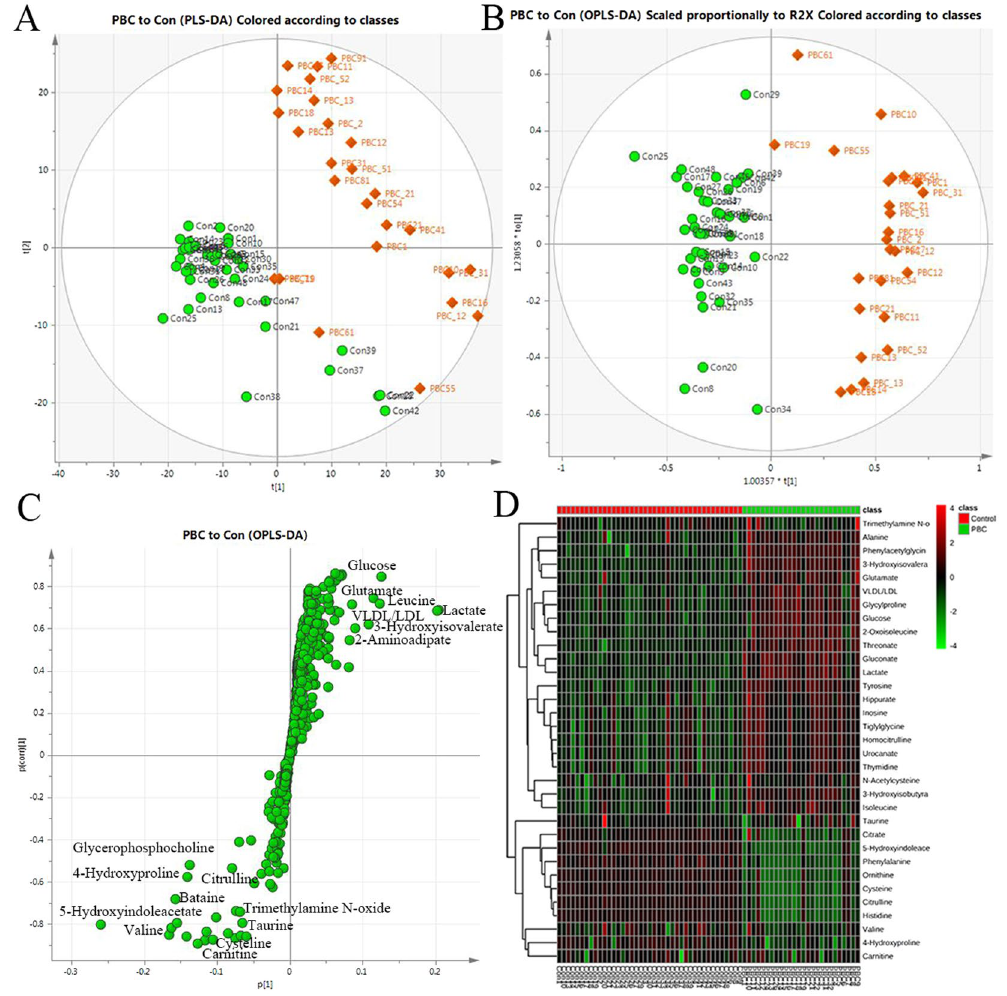
Figure 3. The serum PCA score plot ( A ), OPLS-DA ( B ), S-plot ( C ) and heat map ( D ) used to classify the PBC patients and healthy controls gained a clear separation and identified 33 metabolites. These metabolites could distinguish between the PBC patients and healthy